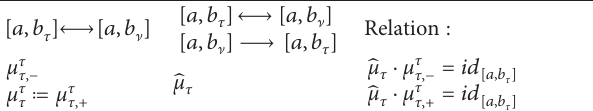
Table 2: The mappings in the first column are strictly ascending left and right continuous versions of ] τ while the mapping in the second column is absolute continuous and